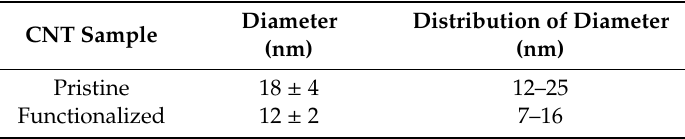
Figure 7. Morphological characterization: ( a ) field emission scanning electron microscopy (FESEM) image of ZrO 2 -fCNTs. Transmission electron microscopy (TEM) image of ( b ) fCNTs and ( c ) ZrO 2 -fCNTs nanostructure system. ( d ) Atomic force microscopy (AFM) amplitude image of ZrO 2 -fCNTs. ( e ) Energy dispersive spectrometer (EDS) analysis of area in ( a ). Table 5. Diameter distribution of CNT samples.